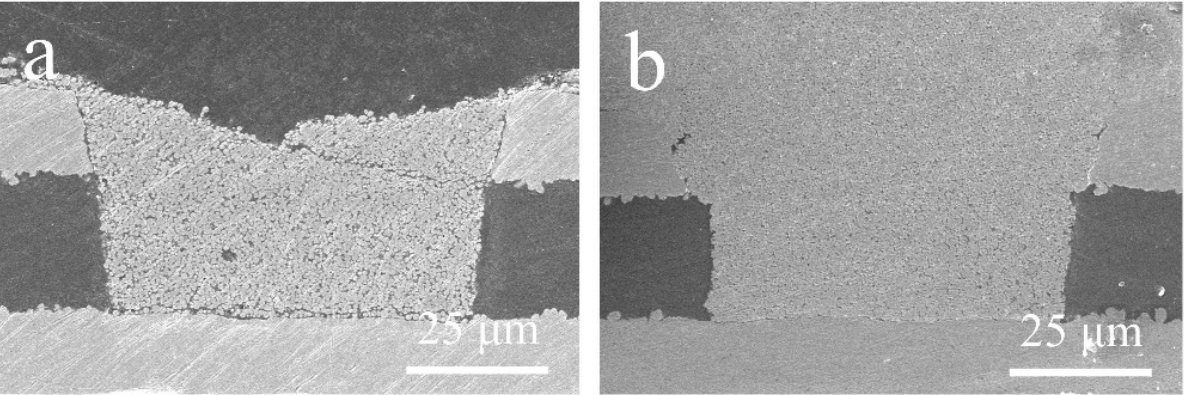
Figure 11. Cross-section images of the microvias filled with Cu@Ag NMPs at the sintering temperatures of 260 °C by ( a ) stencil printing method and ( b ) dense refill method.